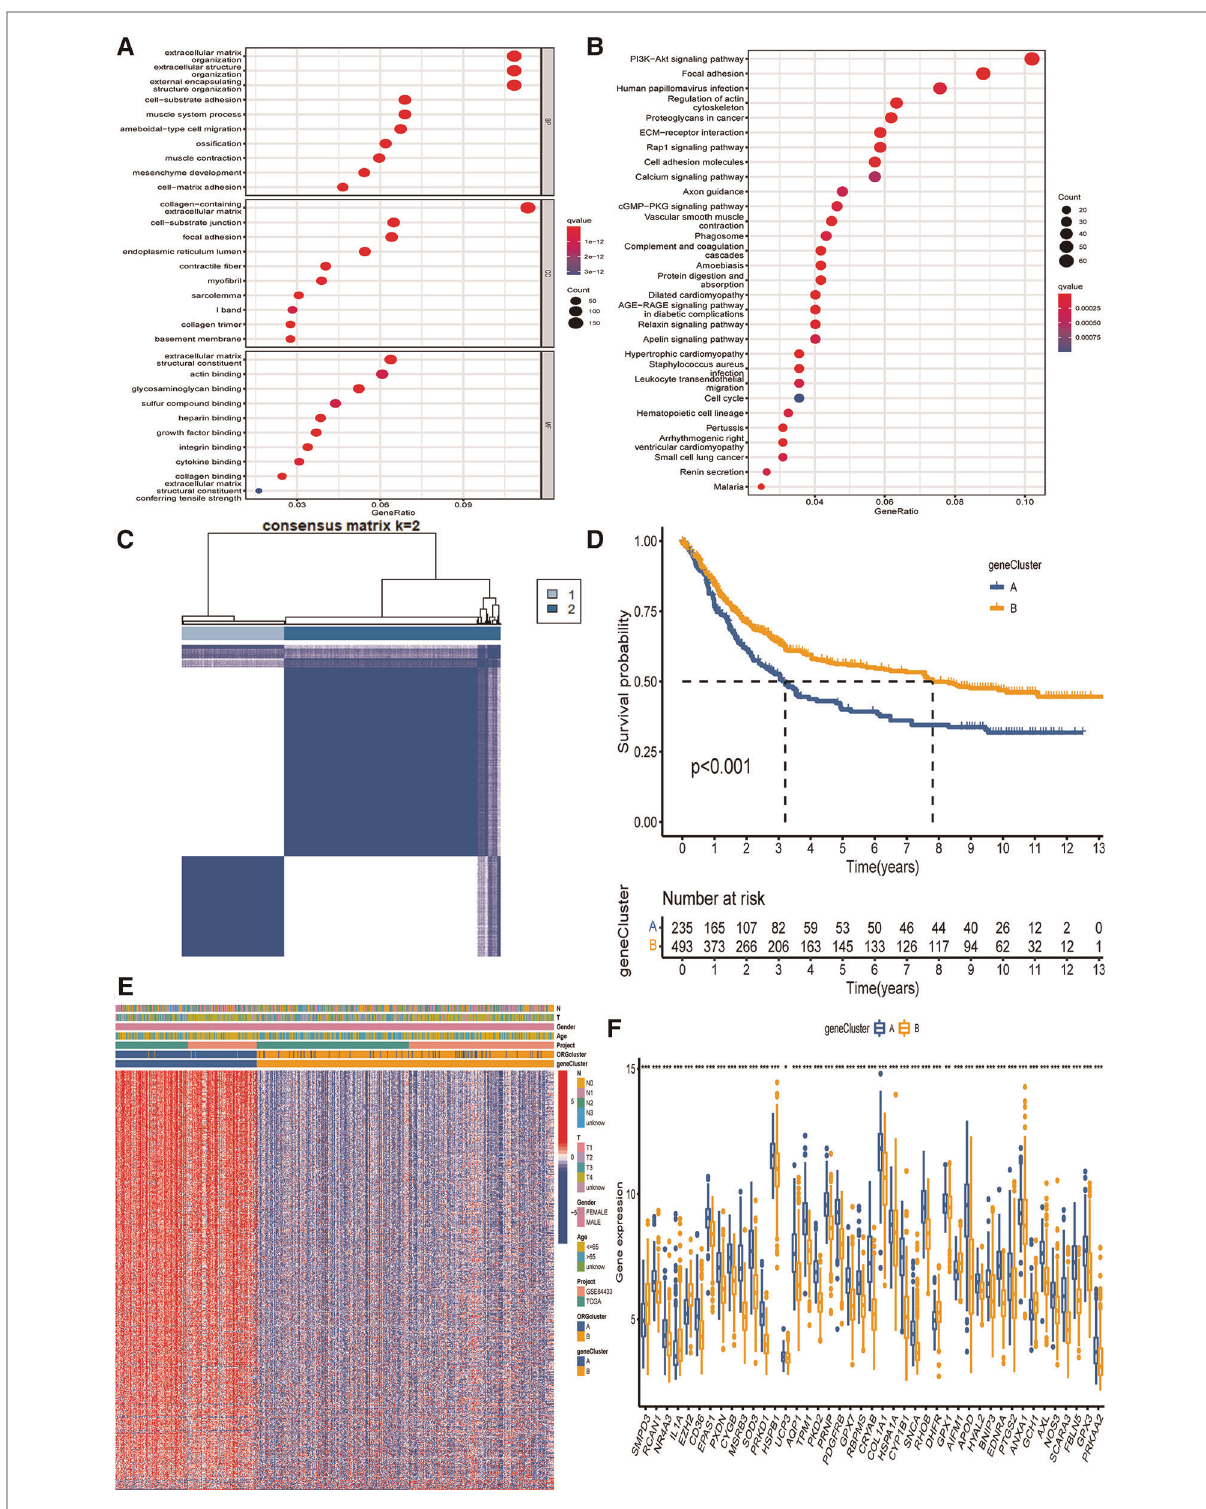
FIGURE 3 The determination of genecluster and the study of subtype function. ( A,B ) GO and KEGG on the enrichment of DEGs in difference pathways. ( C ) The clustering results of genecluster were divided into subtype A ( n =236) and subtype B ( n =496). ( D ) Survival analysis results of gene subtypes. ( E ) The difference in the expression of genes involved in the construction of the model between the two subtypes. ( F ) 43 genes involved in ORGcluster also showed differential expression in genecluster. GO, Gene Ontology; KEGG, Kyoto Encyclopedia of Genes and Genomes; DEGs, differentially expressed genes; ORGs, oxidative stress-related